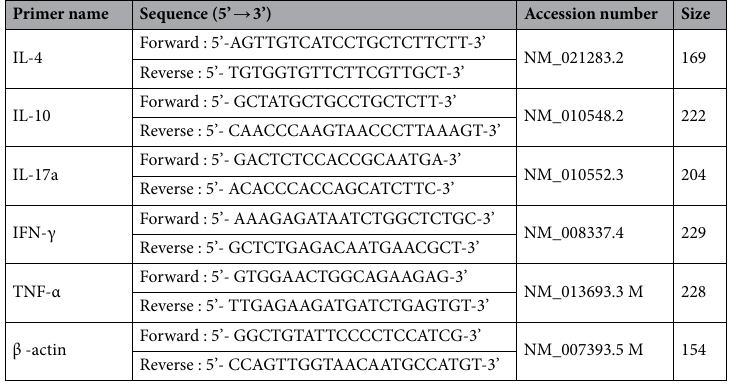
Table 1. The sequences of the applied primers in